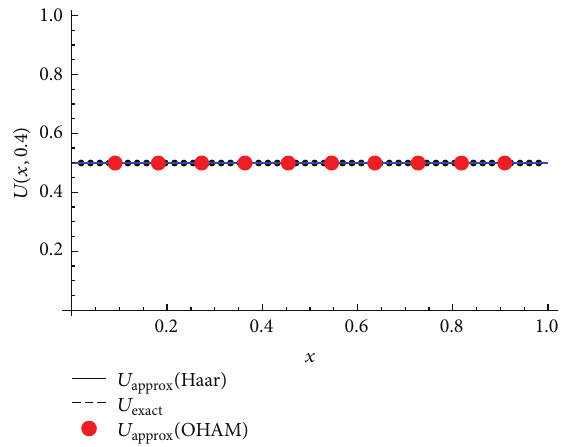
Figure 2: Comparison of Haar wavelet solutions and OHAM solutions with the exact solution of Burgers-Fisher equation when 𝑡 = 0.4 .